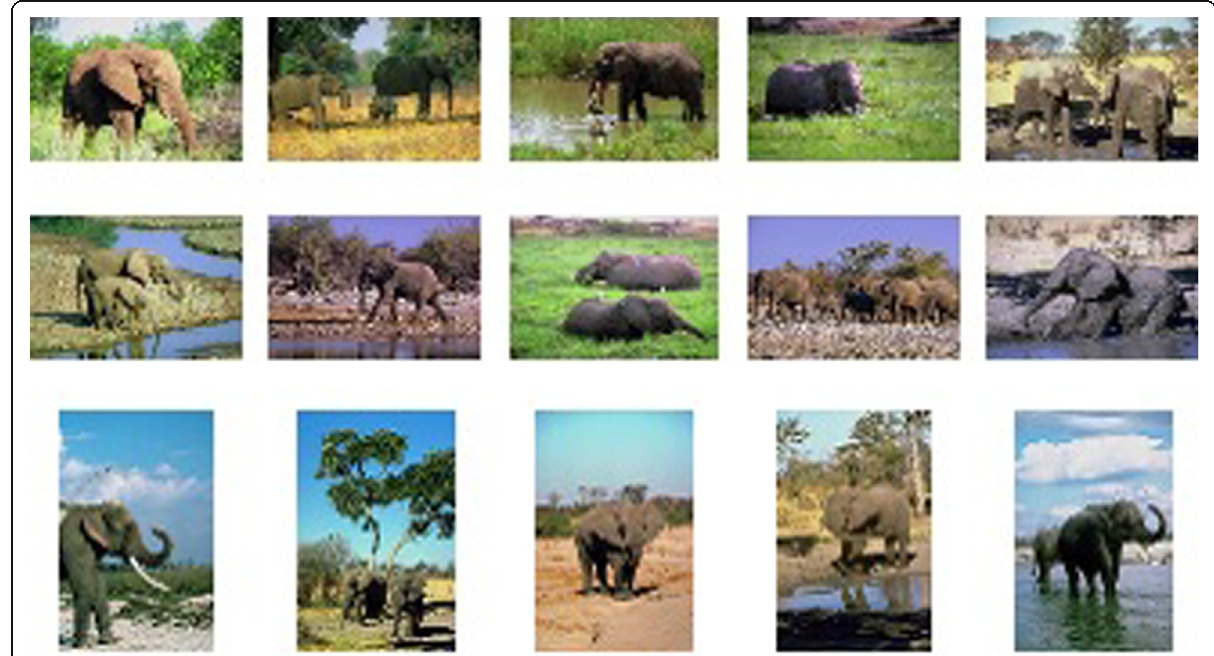
Fig. 2 Elephants in different environments and different